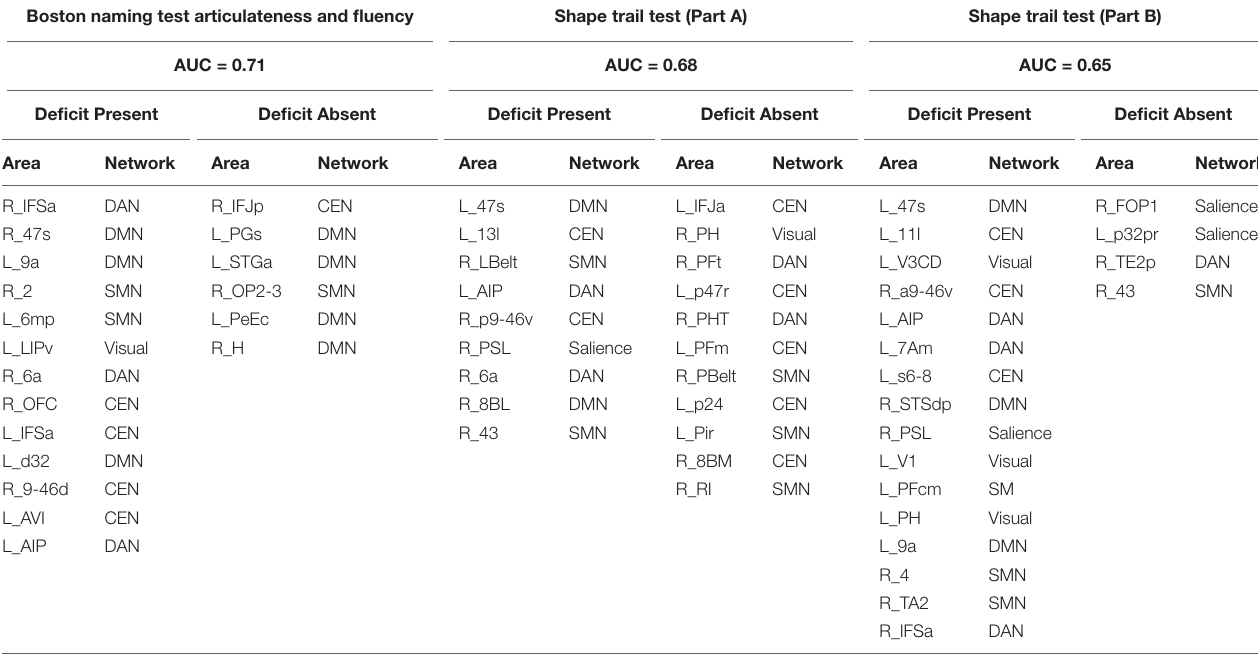
TABLE 3 | Predictors of performance in neuropsychiatric tests associated with attention and executive function. Boston naming test articulateness and fluency Shape trail test (Part A)